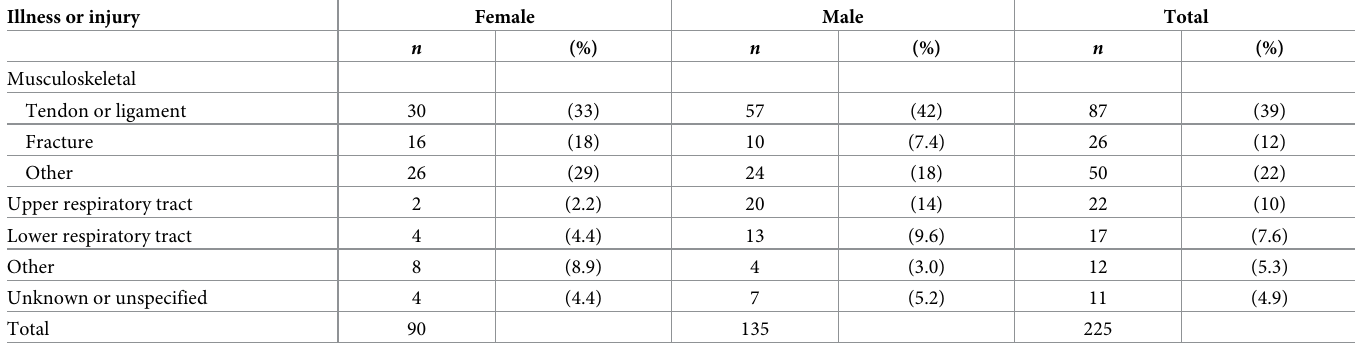
Table 4. Injuries or illnesses leading to retirement of the survey horses reported as retired, stratified by sex in the 2017–2018 Australian Thoroughbred racing season. Illness or